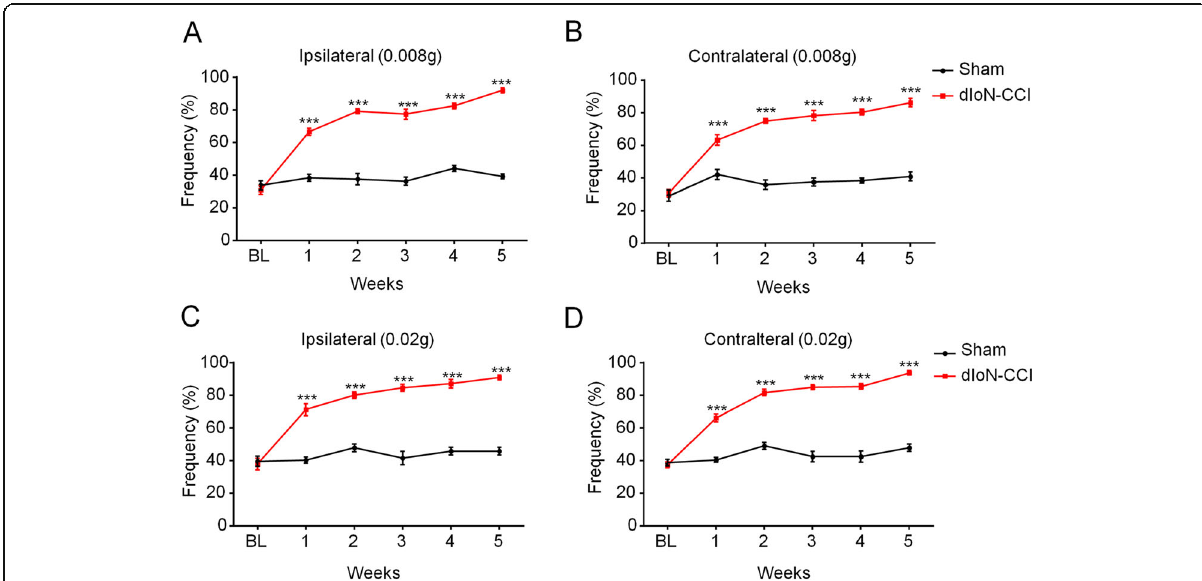
Fig. 1 Bilateral mechanical pain hypersensitivity during 5 weeks following dIoN-CCI surgery in mice. a - b At 0.008 g stimulus intensity, mechanical pain hypersensitivity in dIoN-CCI mice was observed in the ipsilateral ( a ) and contralateral side ( b ) to dIoN-CCI surgery compared with that of sham mice. c - d At 0.02 g stimulus intensity, mechanical pain hypersensitivity in dIoN-CCI mice was observed in the ipsilateral ( c ) and contralateral side ( d ) to dIoN-CCI surgery compared with that of sham mice. Data was expressed as Mean ± SEM. ( n = 8 each group; *** P < 0.001 compared with the sham group, two-way ANOVA with post-hoc Bonferroni test). dIoN-CCI, chronic constriction injury of distal infraorbital nerve; BL,